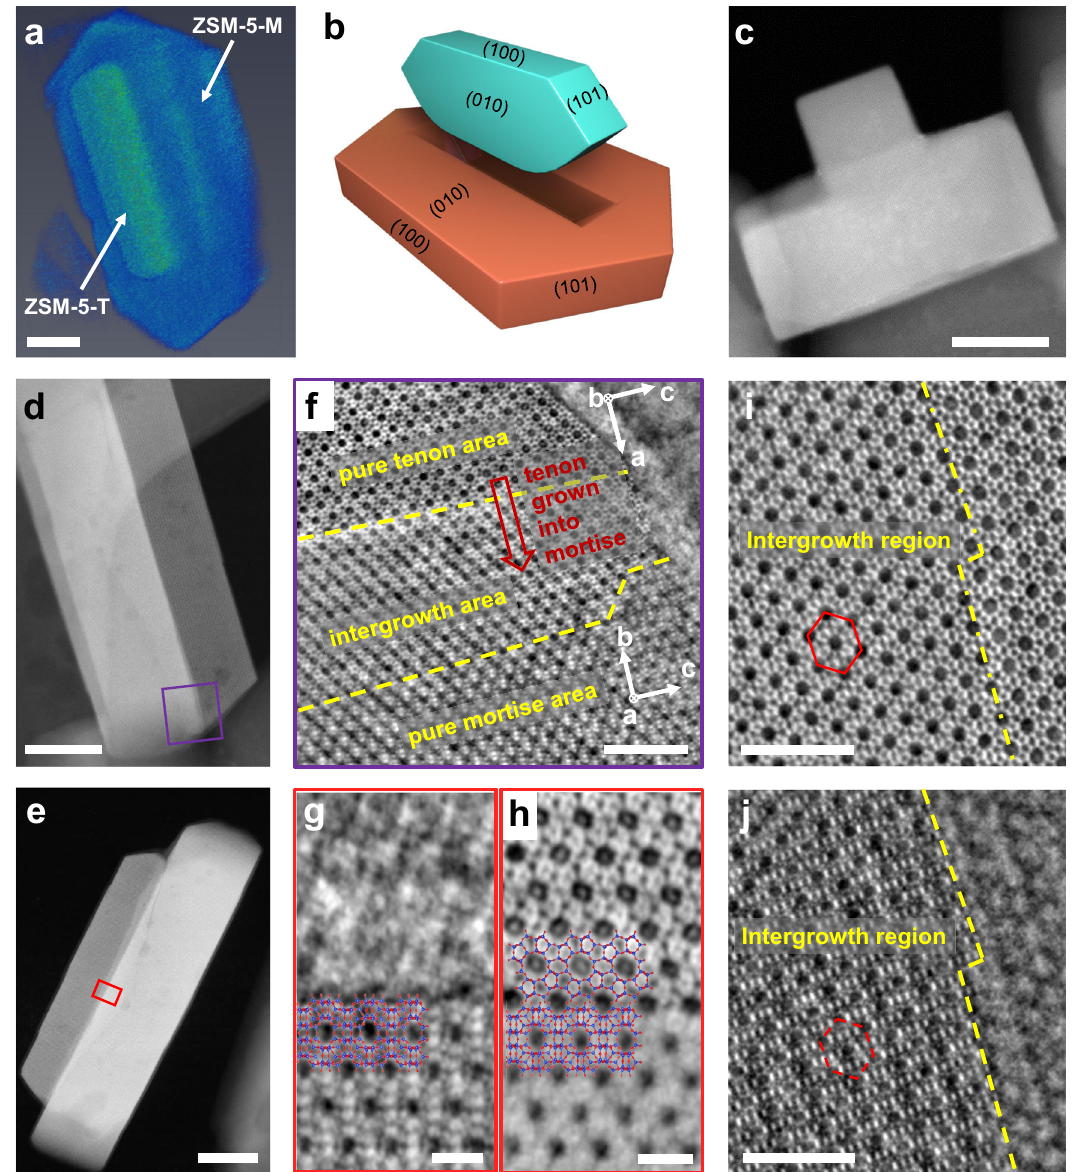
Fig. 1 Revealing morphology of ZSM-5-MT catalyst. a 3D electron tomographic reconstruction of individual ZSM-5-MT nanocrystal. b Schematic model of ZSM-5-MT nanocrystal with tenon and mortise subunit. c ADF-STEM image of ZSM-5-MT from the [001] projection. d – h ADF- and iDPC-STEM images revealing the intergrowth structures in ZSM-5-MT from the lateral projection. It is shown that the mortise and tenon grow into each other with perfect connection of different types of channels. The orientation of the crystallographic a , b, and c axes are labeled for two subunits in ( f ). i , j Imaging the straight channels in mortise and the sinusoidal channels in tenon at the same area by the iDPC-STEM imaging with different defocuses. Scale bars, 50 nm in ( a ) and ( c - e ), 5 nm in ( f , i , and j ), 2 nm in ( g , h